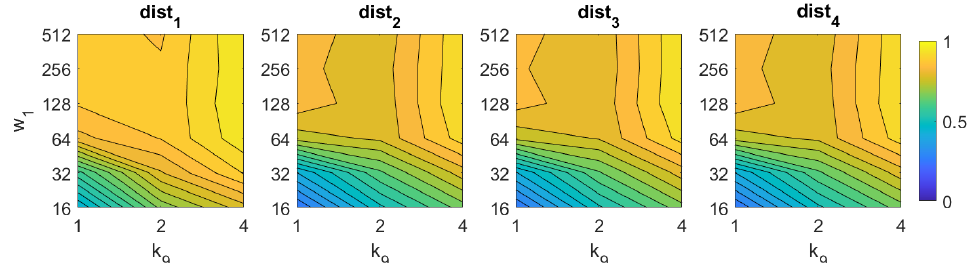
Figure 8. Gist image retrieval problem. Success rate of the method. k 7 is the number of horizontal blocks and m 1 the number of Gabor filters to build the descriptor (Table 1).